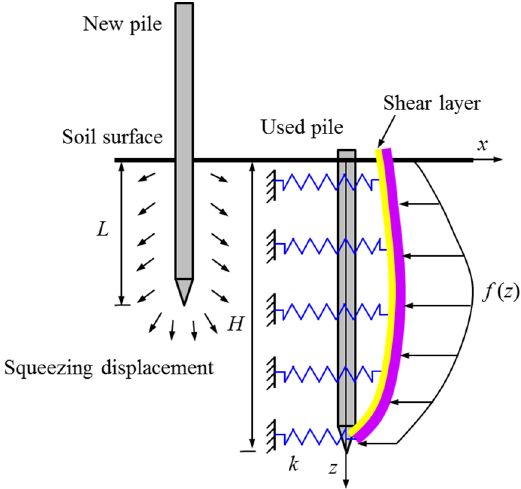
Figure 5. Pile–soil interaction model for Pasternak foundation.